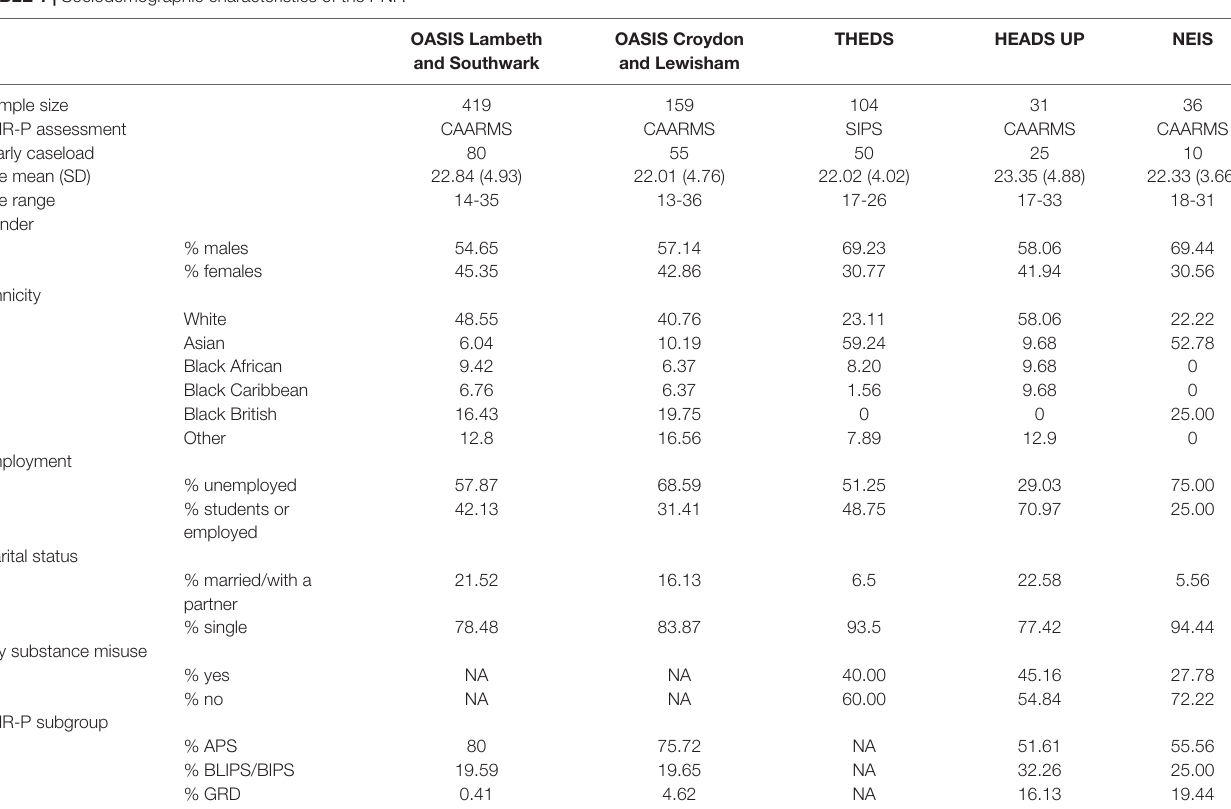
OASIS Lambeth OASIS Croydon THEDS HEADS UP NEIS and Southwark and Lewisham